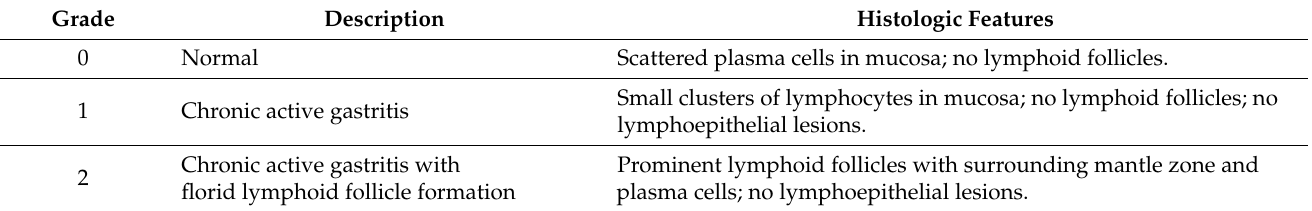
Table 1. Histologic scoring system for the diagnosis of gastric MALT lymphoma (Wotherspoon score) [4].